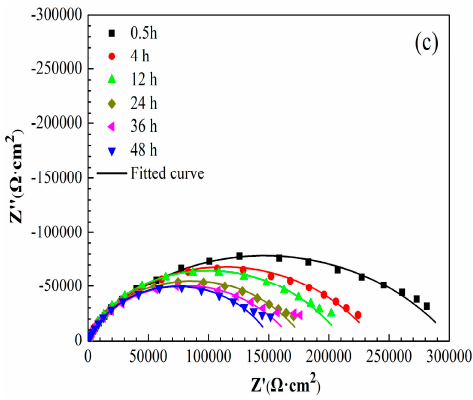
Figure 10. Nyquist plots of ( a ) bare copper electrode, ( b ) copper electrode with 1-dodecanethiol SAM, and ( c ) H 3 PO 4 -treated copper electrode with 1-dodecanethiol SAM in 3.5% NaCl solution at different times. Table 5. Electrochemical impedance parameters of bare copper electrode. Sample